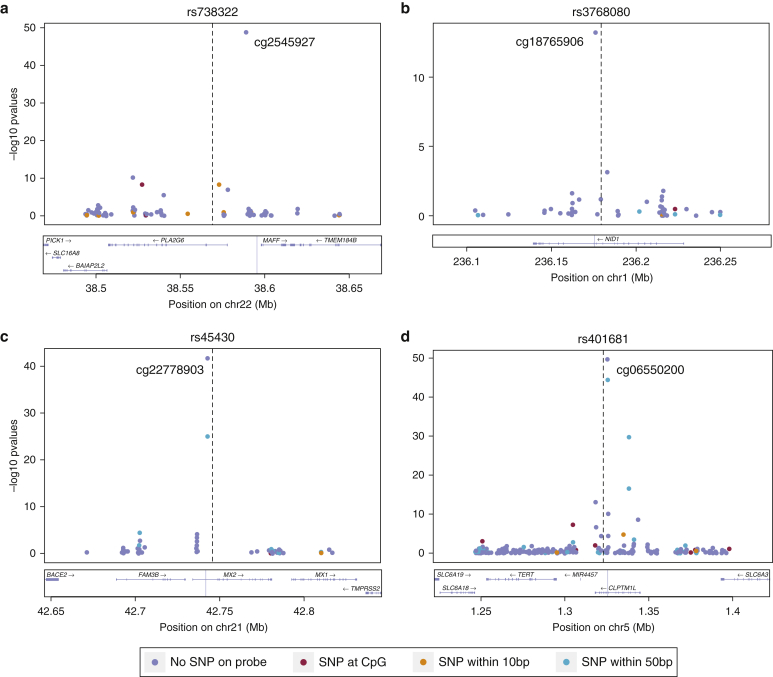
GWAS SNPs for nevus count or melanoma risk versus DNA methylation in skin tissue in cis. Regional plot of 100 kb flanking regions around the GWAS SNP of interest denoted as a striped black line. Each point is a CpG site with its P-value on the y-axis. The plots are annotated with a gene track from LocusZoom. Each point is colored according to the occurrence of genetic variants on the probe sequence (see the legend): (a) rs738322 identified for cutaneous nevi; (b) rs3768080 identified for cutaneous nevi; (c) rs45430 identified for melanoma risk; (d) rs401681 identified for melanoma risk. GWAS, genome-wide association studies; SNP, single nucleotide polymorphism.